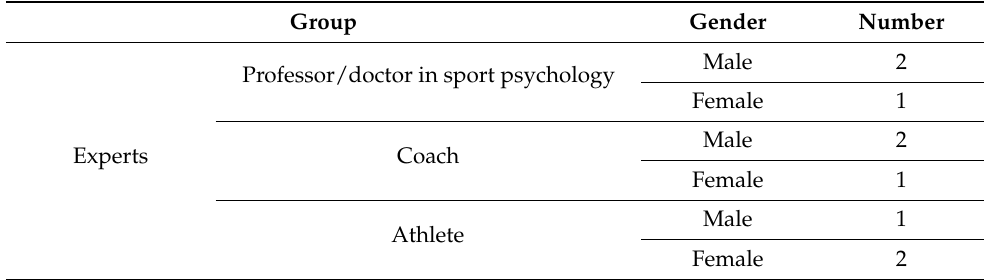
Table 1. General characteristics of the expert group.